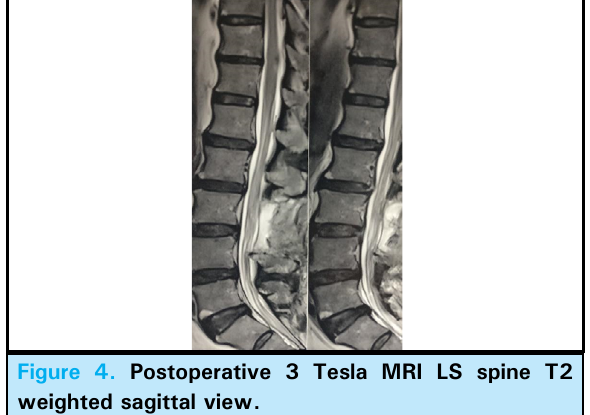
Figure 4. Postoperative 3 Tesla MRI LS spine T2 weighted sagittal view.